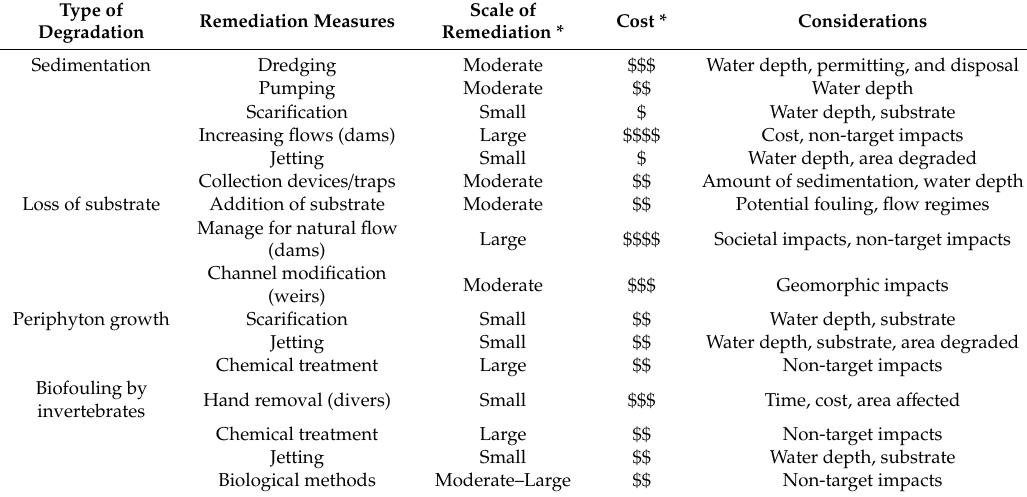
Table 2. Types of rocky spawning habitat degradation, remediation measures, potential scale (small to large) of remediation measures, cost (low to high), and considerations for remediation.